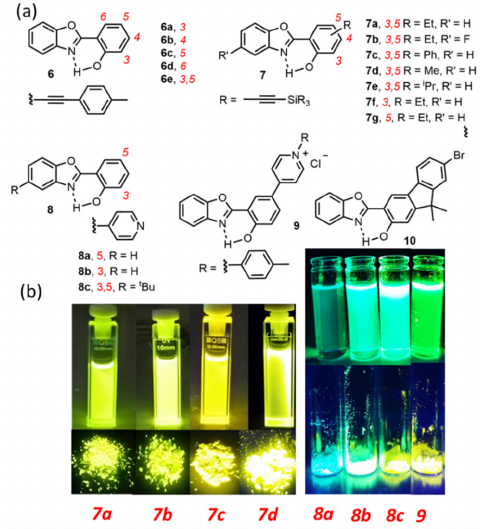
Figure 4. ( a ) Examples of HBO dyes showing DSE properties [67–72] and ( b ) Photographs of HBO dyes 7a–d and 8a–c / 9 under irradiation in solution (toluene or dichloromethane) and as powders ( λ exc = 365 nm) [69,71]. Adapted from Ref. [69] Copyright 2019 Elsevier. Adapted from Ref. [71] Copyright 2021 American Chemical Society.